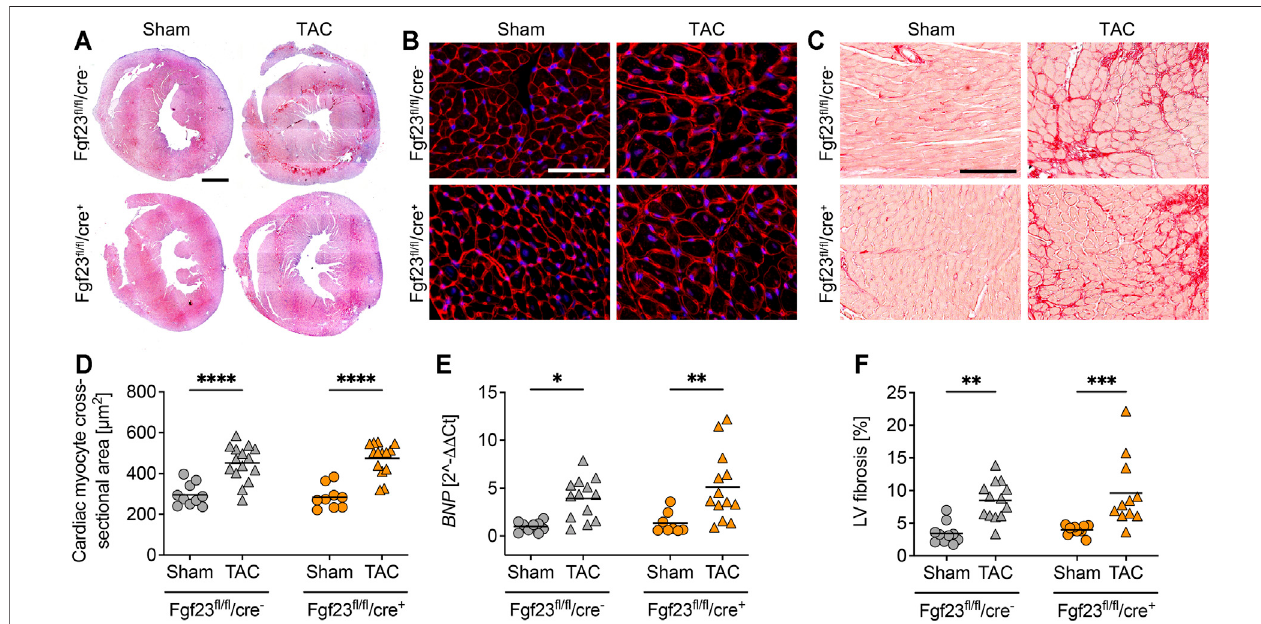
FIGURE 6 | Cardiac hypertrophy and left ventricular fi brosis is equally distinct in Fgf23 fl / fl /cre − and Fgf23 fl / fl /cre + mice. (A) Representative heart cross-sections of sham and TAC-operated Fgf23 fl / fl /cre − and Fgf23 fl / fl /cre + mice stained with hematoxylin and eosin (H and E). Magni fi cation × 10, scale bar 500 µm. (B) Representative cardiac cross-sections of sham and TAC-operated Fgf23 fl / fl /cre − and Fgf23 fl / fl /cre + mice stained with wheat germ agglutinin (WGA) Alexa Fluor 555 (red) and DAPI for nuclei(blue).Magni fi cation × 10,scalebar50 µm. (C) TACincreasescardiac myocytecross-sectionalareainboth genotypes. (D) Cardiac mRNAexpressionlevels of BNP are induced by TAC in Fgf23 fl / fl /cre − and Fgf23 fl / fl /cre + mice. (E) Representative images of picrosirius red-stained cardiac mid-chamber free-wall of sham and TAC-operated Fgf23 fl / fl /cre − and Fgf23 fl / fl /cre + mice. Magni fi cation × 10, scale bar 100 µm. (F) Quanti fi cation of collagen fi bers reveals increased left ventricular (LV) fi brosis in both Fgf23 fl / fl /cre − and Fgf23 fl / fl /cre + mice after TAC. Data is given as scatter dot plots with means; * p < 0.05, ** p < 0.01, *** p < 0.001, and **** p < 0.0001 analyzed by Two-way ANOVA followed by Tukey ’ s multiple comparison test; n (cid:2) 8 – 15 mice per